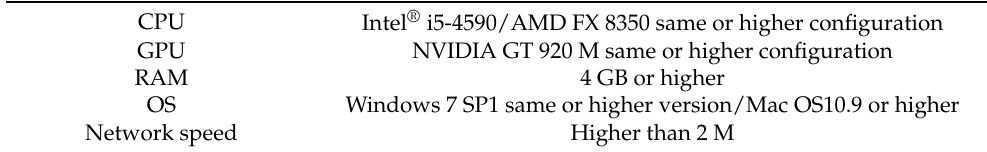
Table 4. Recommended computer